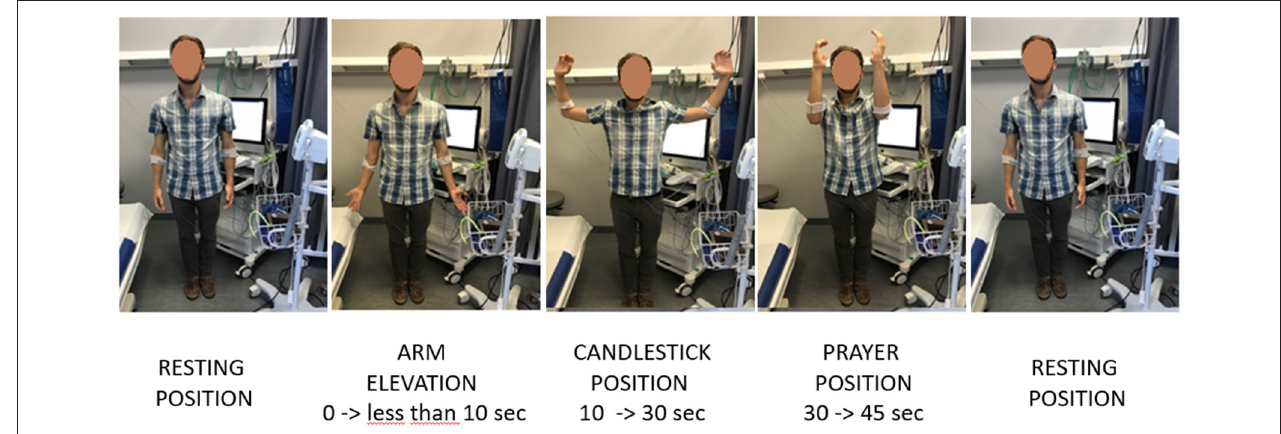
FIGURE 1 | Procedures of arm positioning used in the present study.